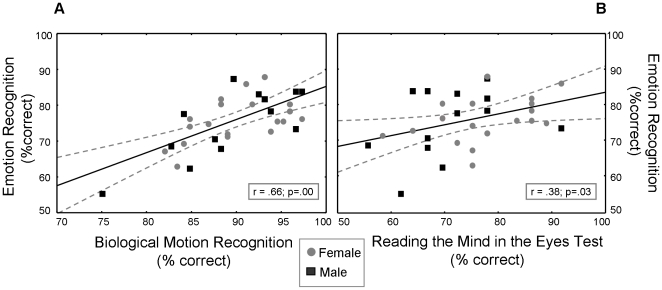
Performance on the ‘Emotion Recognition Test’ correlates with performance on the ‘Biological Motion Recognition Test’ and the ‘Reading the Mind in the Eyes Test’.
Figure 3 shows linear fits for correlated performance (% correct answers) on the ‘Emotion Recognition Test’ and respectively the ‘Biological Motion Recognition Test’ (A) and the ‘Reading the Mind in the Eyes Test’ (B) of experiment 2. Dotted lines denote 0.95 confidence intervals.